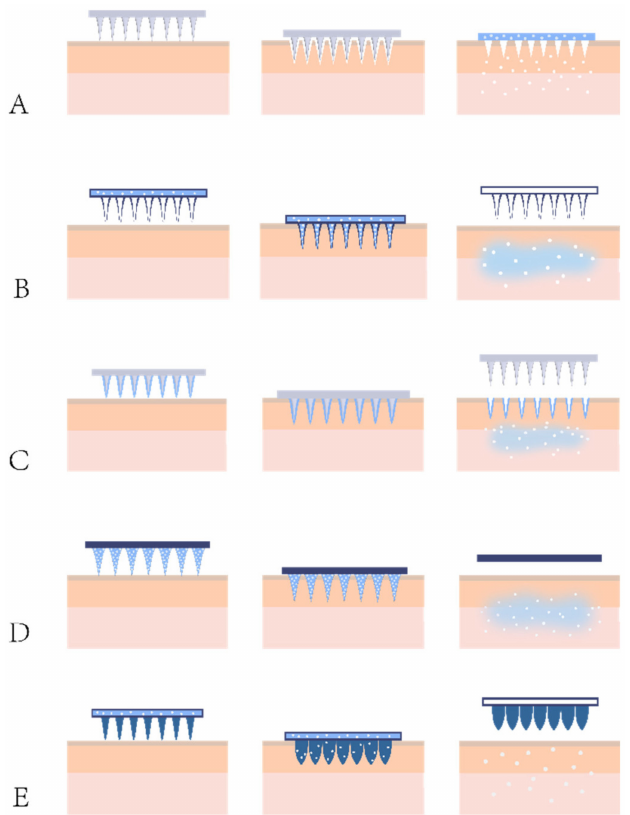
Figure 1. Drug delivery mechanisms for various types of MNs. ( A ) Solid MNs: Used for skin pretreatment, forms microchannels and is then removed, followed by the use of a topical formulation containing the drug for delivery of the drug through the microchannels, ( B ) Hollow MNs: After insertion into the skin, the drug loaded in the internal cavity of the MNs flows out, ( C ) Coated MNs: After insertion into the skin, the drug film wrapped in the outer layer of the MNs is released into the body, ( D ) Dissolving MNs: After insertion into the skin, the MN matrix dissolves into the body along with the drug encapsulated in it, ( E ) Hydrogel-forming MNs: After insertion into the skin, the MNs expand to form microchannels inside but does not dissolve, and the drug enters the body through the